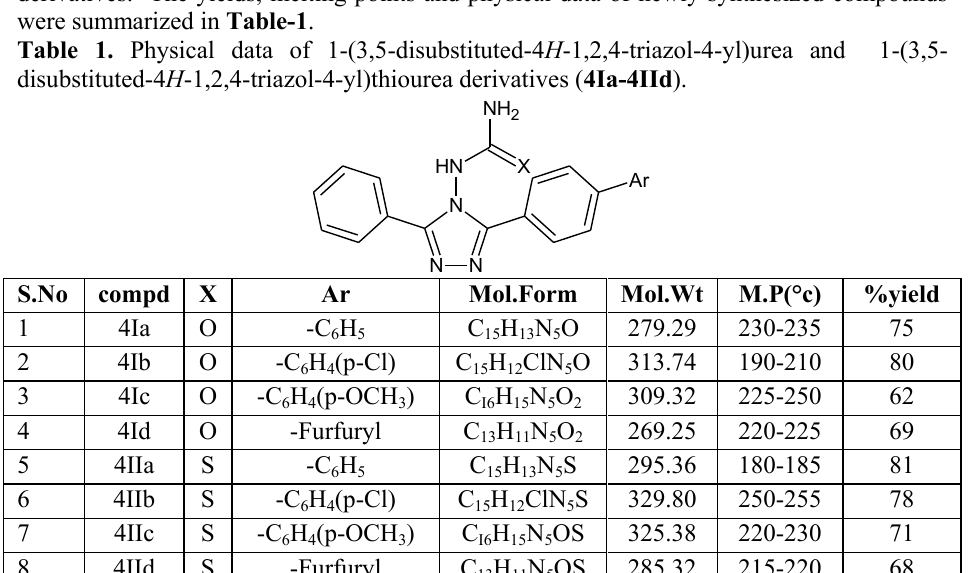
Table 1. Physical data of 1-(3,5-disubstituted-4 H -1,2,4-triazol-4-yl)urea and